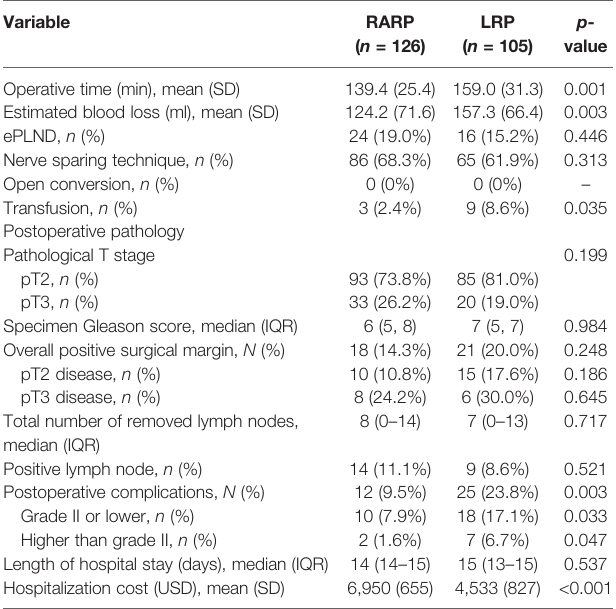
TABLE 2 | Perioperative outcomes following robot-assisted radical prostatectomy (RARP) and laparoscopic radical prostatectomy (LRP). Variable